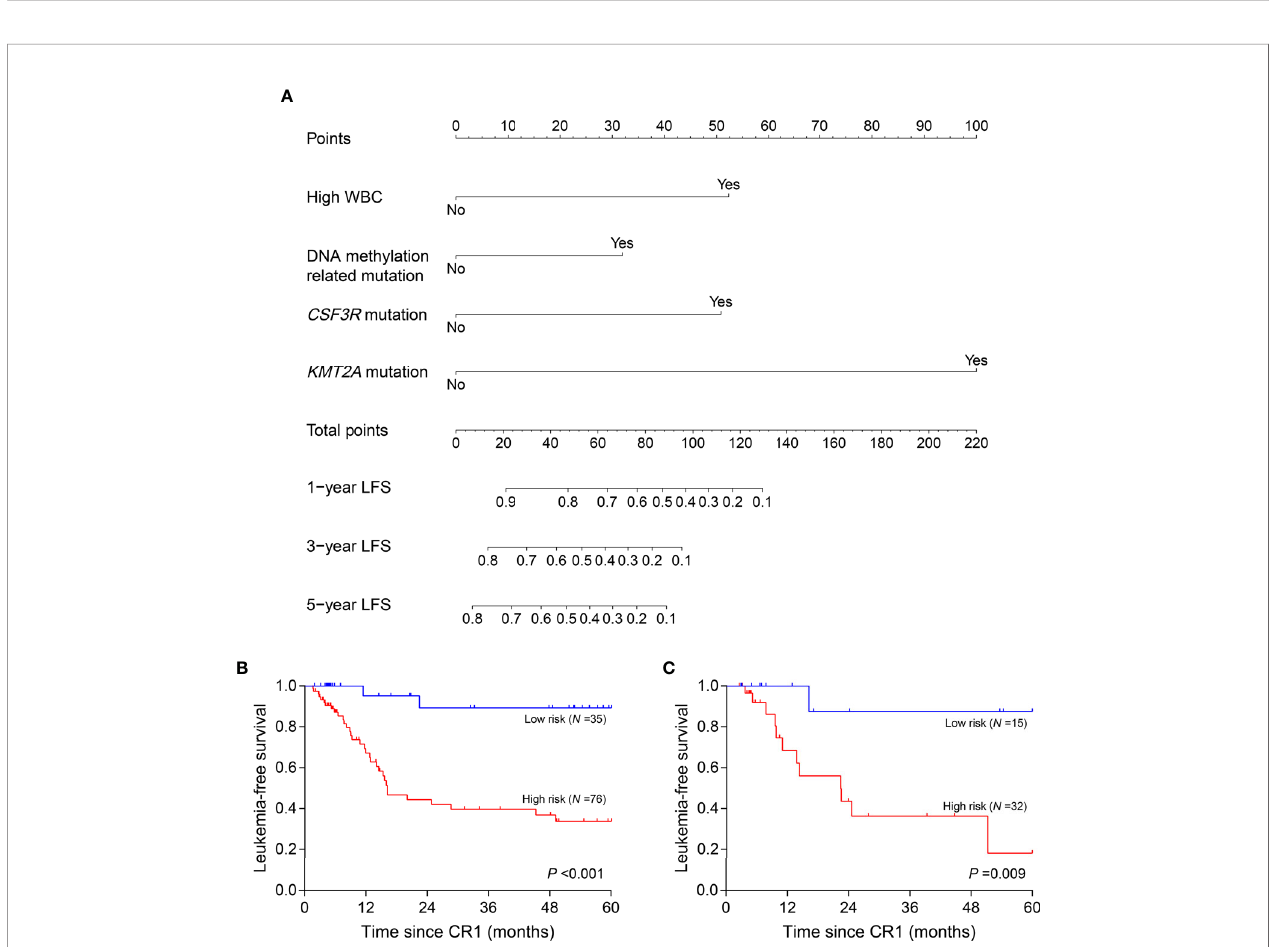
FIGURE 4 | Nomogram model and risk strati fi cation. (A) For WBC, “ Yes ” represents WBC >18.30×10 9 /L at diagnosis; for genes or genetic group, “ Yes ” represents mutation. (B, C) Leukemia-free survival analyses by risk strati fi cation in training (B) and validation (C) cohort. WBC, white blood